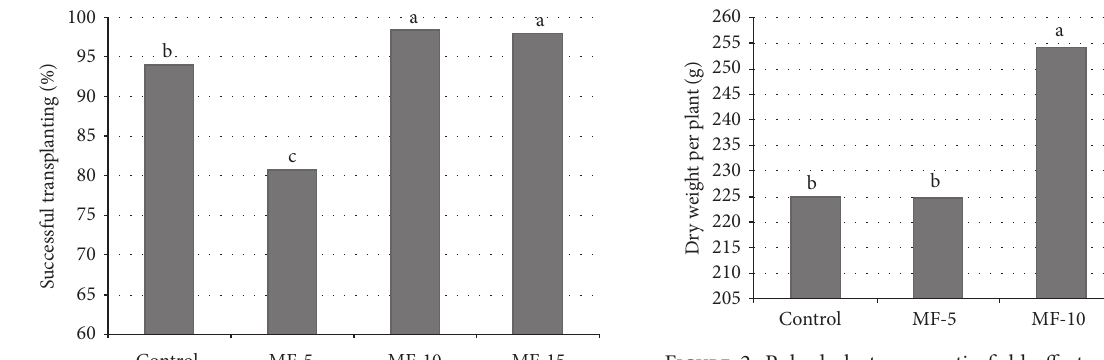
Figure 2: Pulsed electromagnetic field effect on dry weight per plant. Seeds have been exposed for 0, 5, 10, and 15 minutes in magnetic field. Means followed by the same letter for treatments are not significantly different according to the LSD 5% test. Control: untreated seeds; MF-5, MF-10, and MF-15: seeds treated with pulsed electromagnetic field for 5 min, 10min, and 15min,